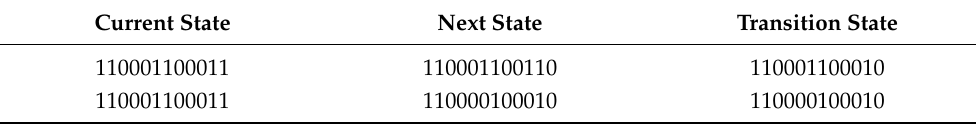
Table 4. Calculation of the dead-time transition